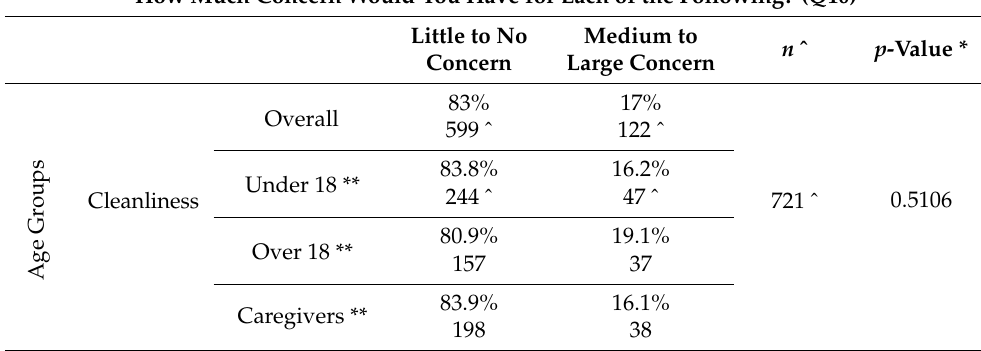
Table 2. The concerns related to animal assisted activity